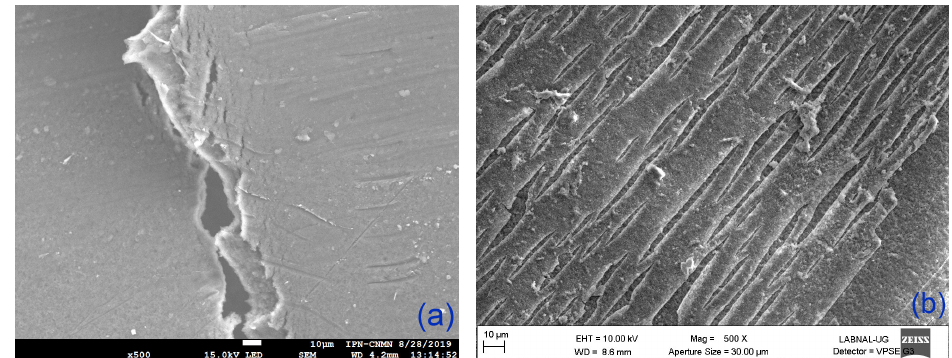
Figure 4. Scanning electron microscopy (SEM) images of the superficial view of ( a ) AEM (500 × ) and ( b ) Modified-AEM (500 × ).